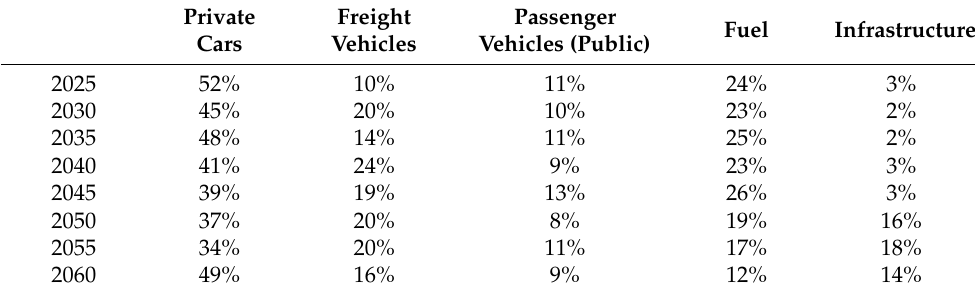
Table 4. Proportion of different costs.